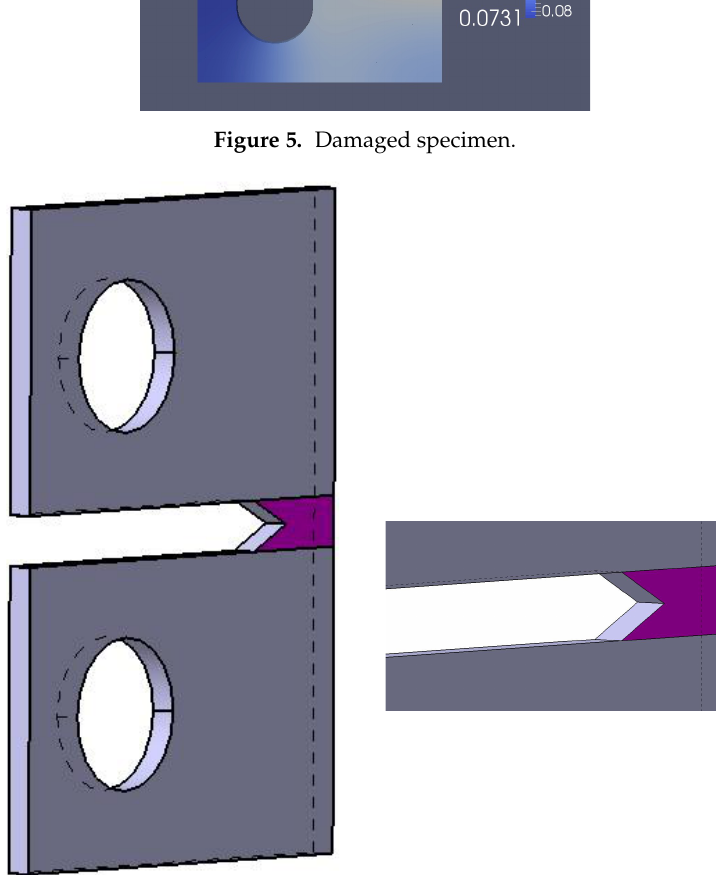
Figure 6. Measurement observed- Case